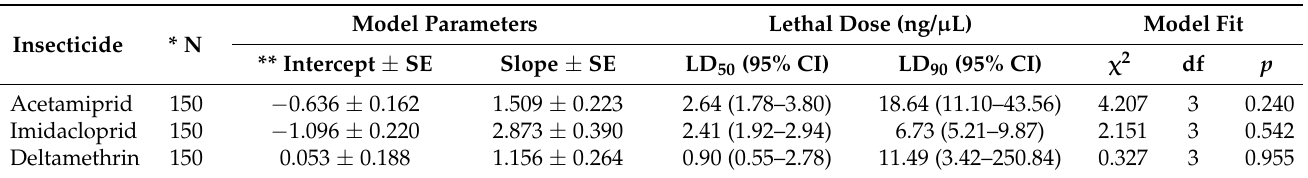
Table 1. Lethal dose (LD 50 , LD 90 ) value of three insecticides against a laboratory strain C. lectularius using topical